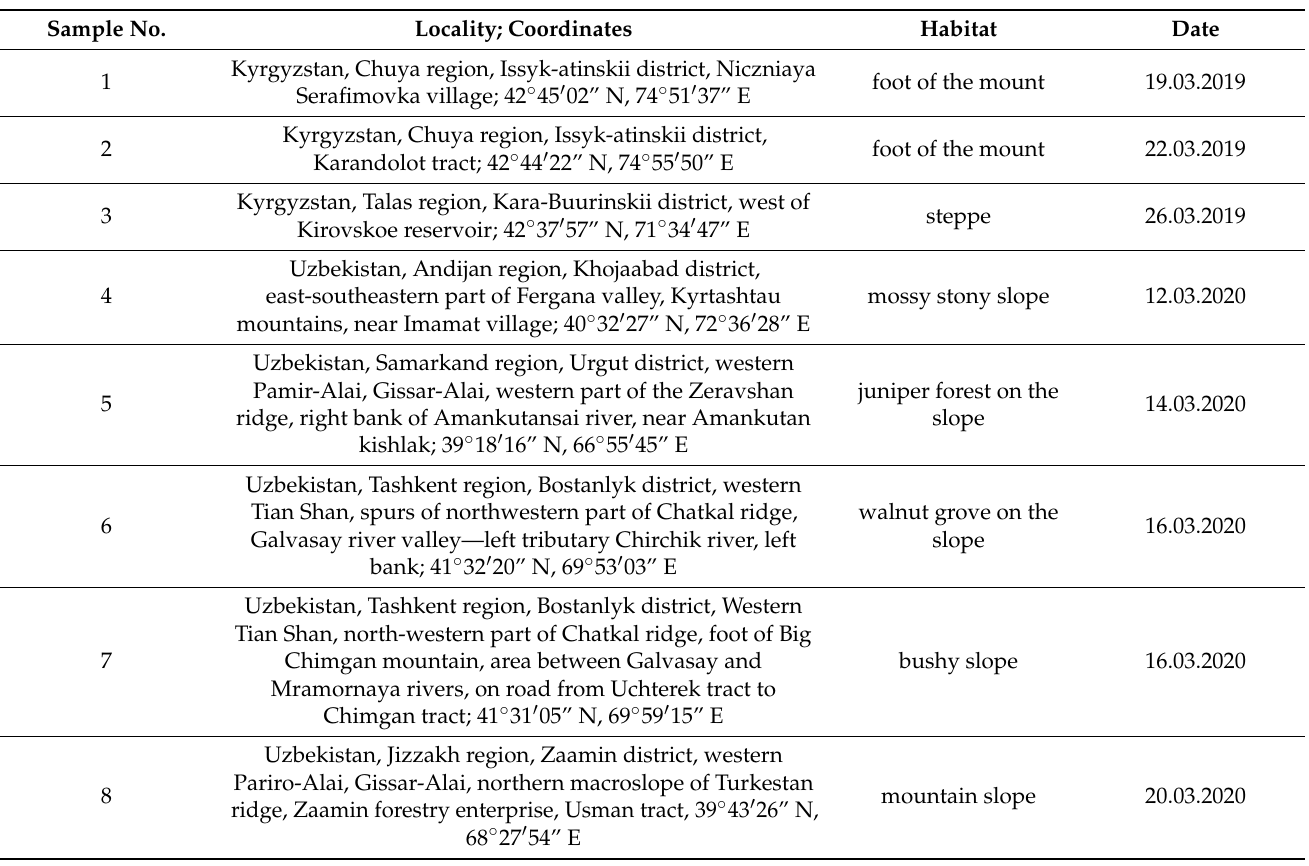
Table 3. Sites of collection of the analyzed